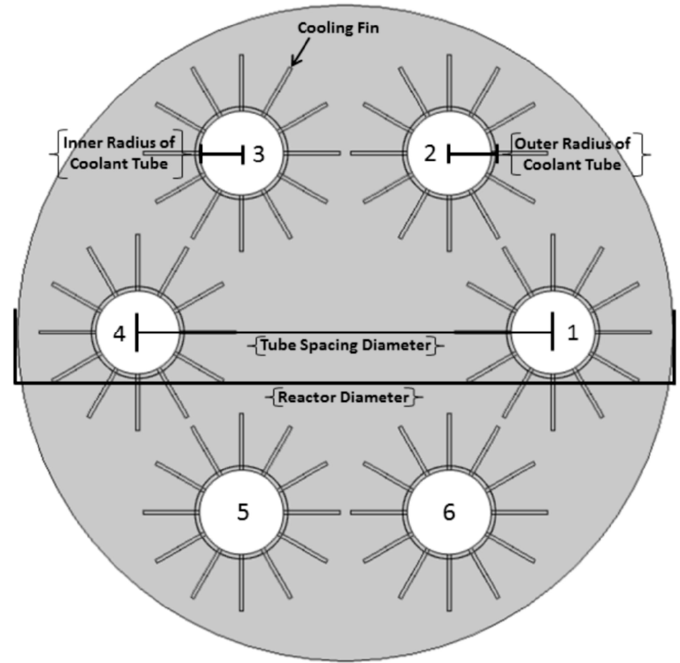
Figure 6. Reactor diagram of a six-pass finned configuration with the tube numbers.